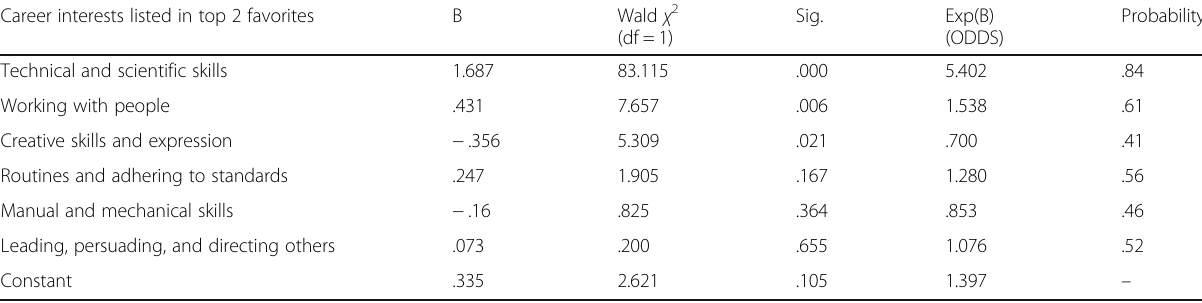
Table 11 Bivariate logistic regression of the correlation between career interests and students being very likely to pursue a STEM